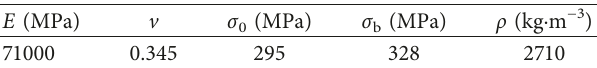
Figure 5: Stress-strain curve. Table 1: Material